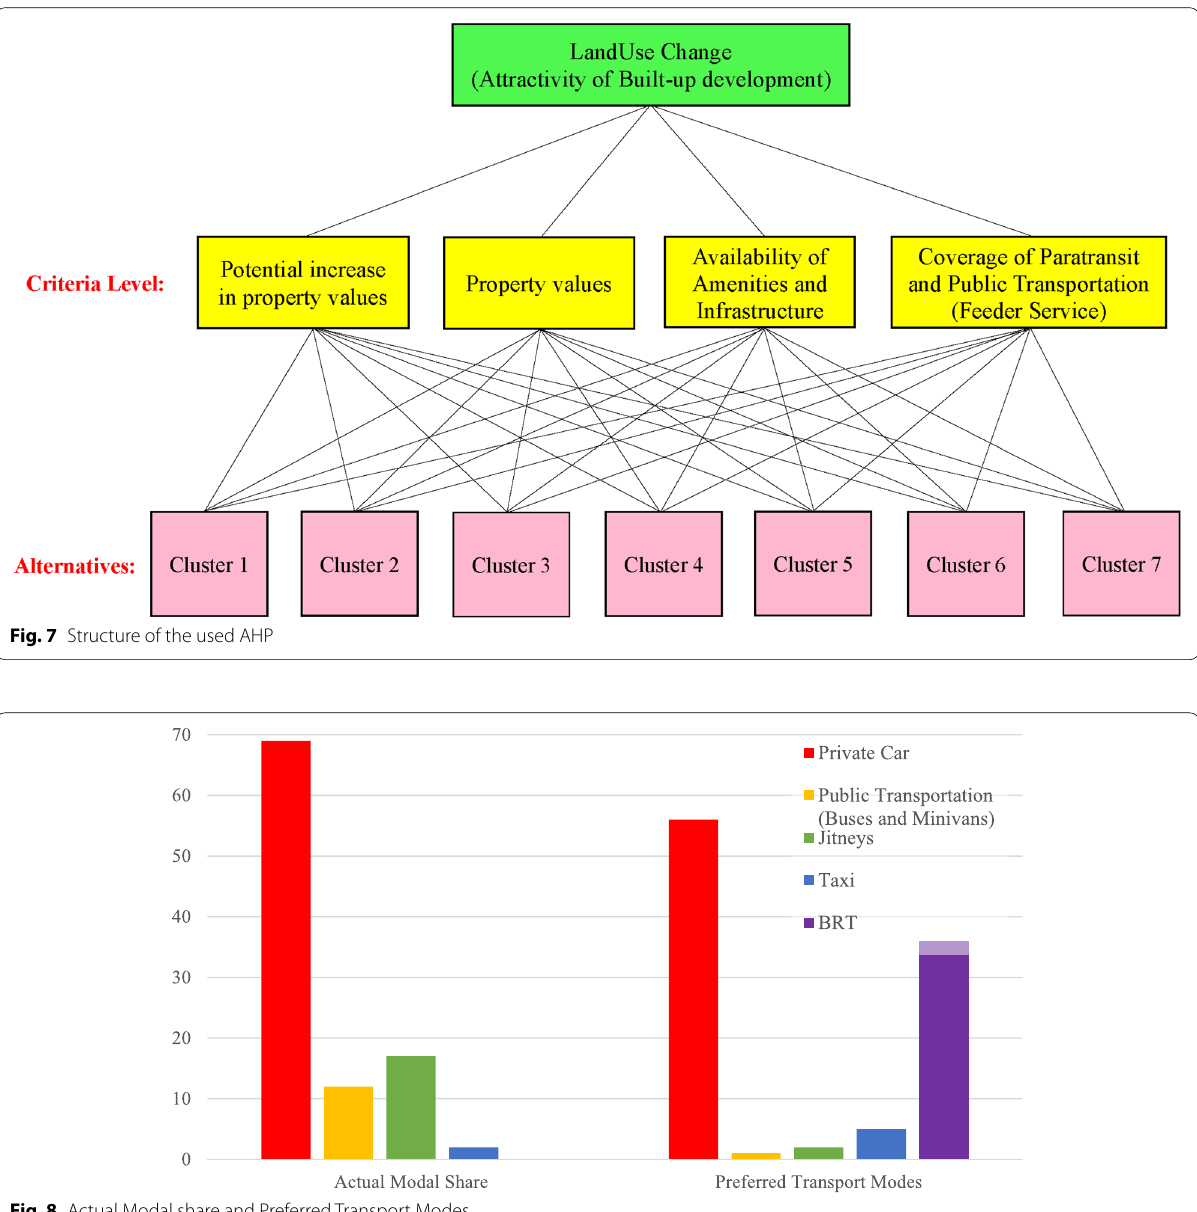
Fig. 8 Actual Modal share and Preferred Transport Modes